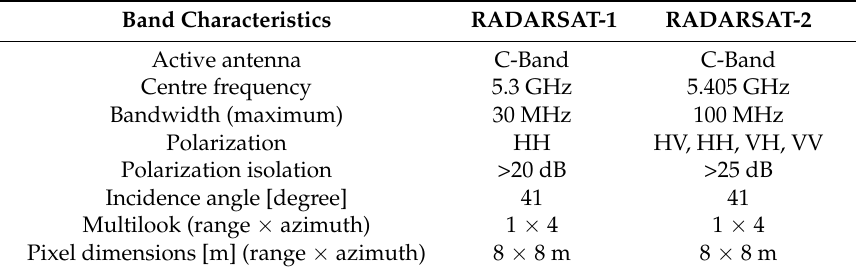
Table 1. Details of the satellite data and resolution.